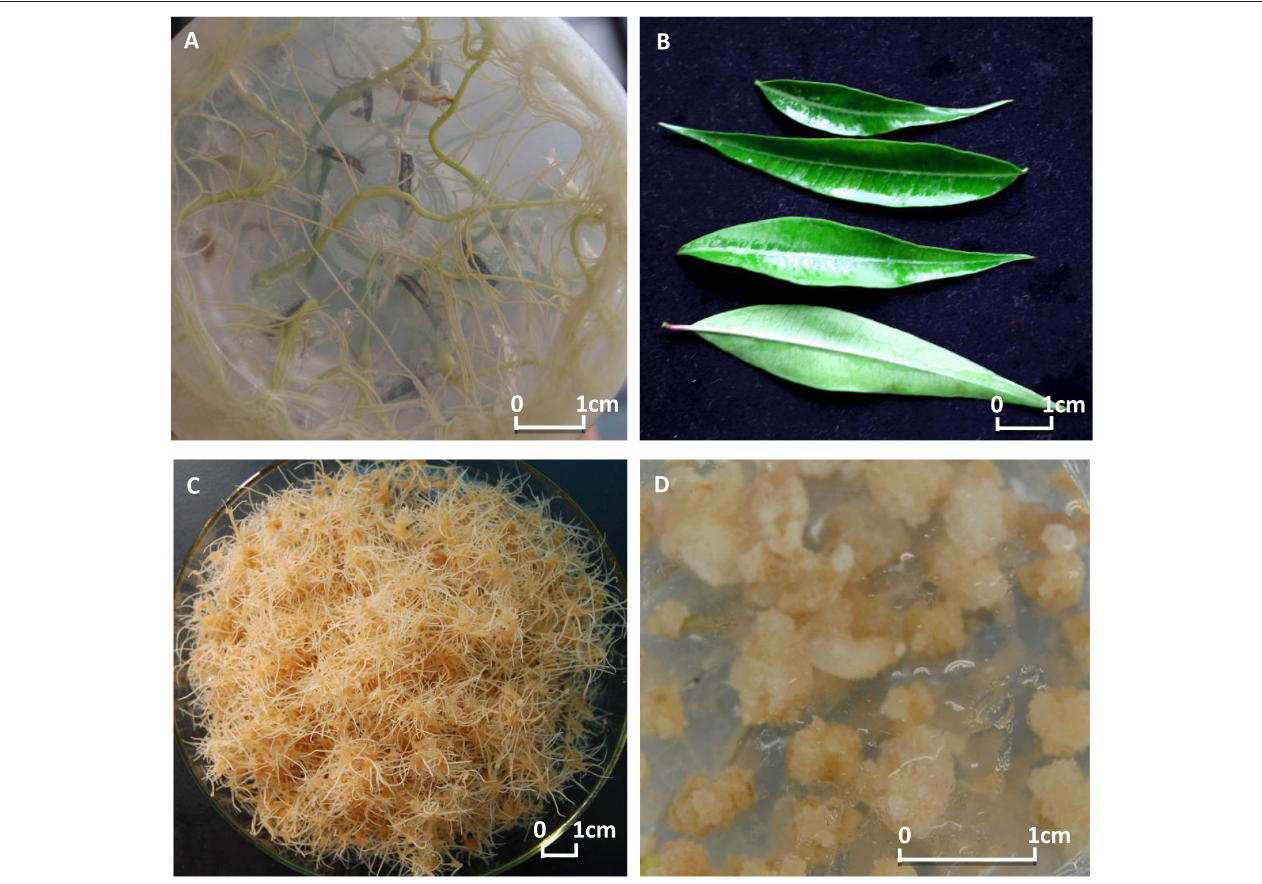
FIGURE 1 | The explants and the induced tissue cultures of Periploca sepium . Shown are the explants of roots (A) and leaves (B) , and the induced tissue cultures of adventitious roots (C) and calli (D)